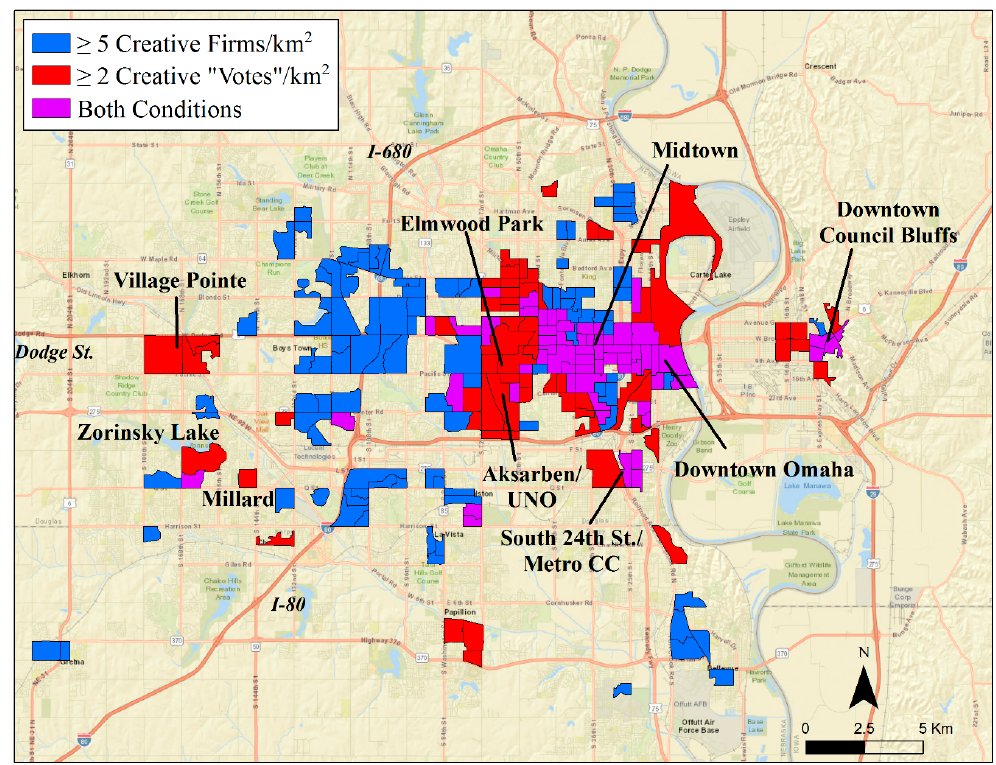
Figure 6. Census block groups with top quartile creative firm density ( ≥ 5/km 2 ), top quartile creative “votes” density ( ≥ 2/km 2 ), or both.